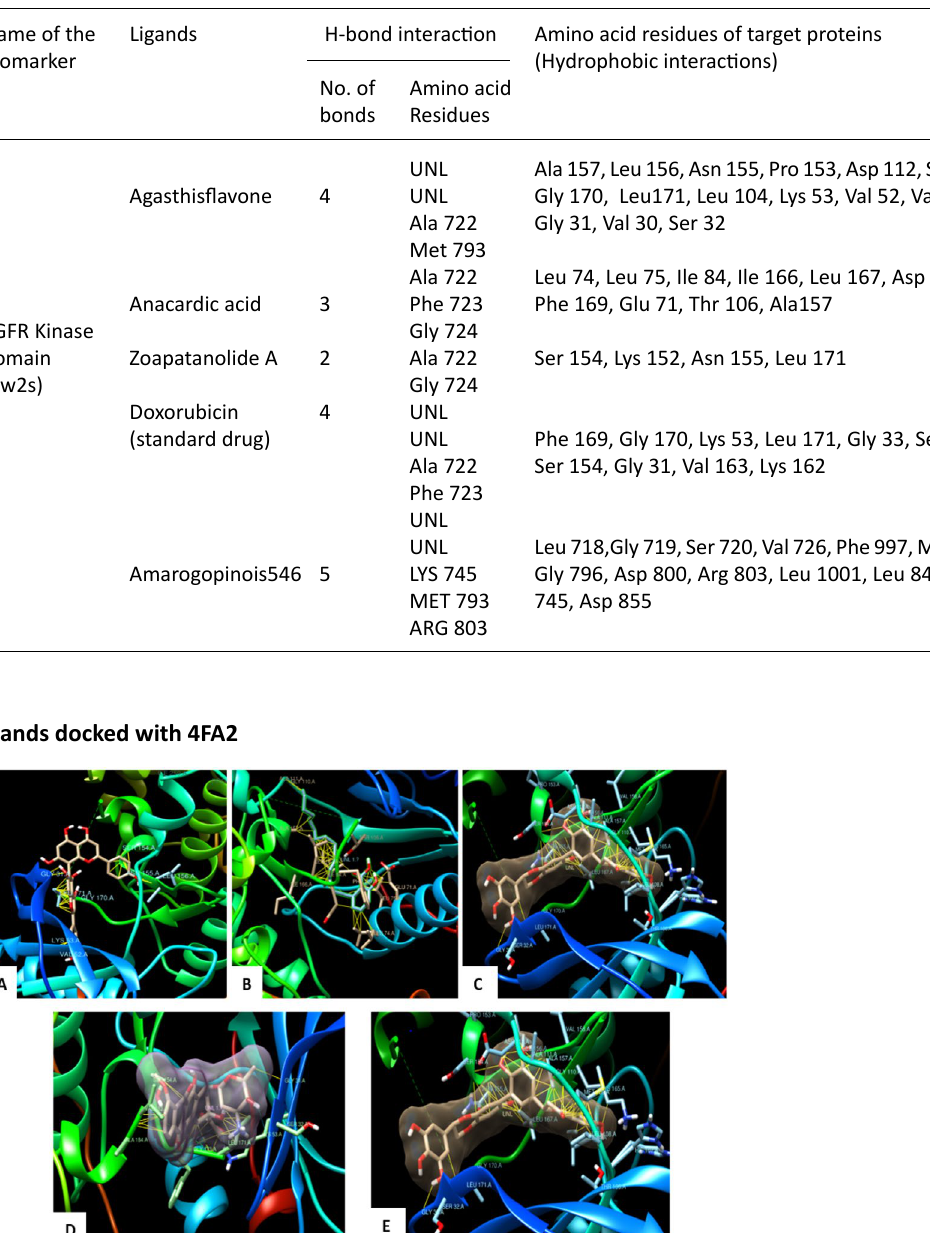
table 3. Residues of the target molecule EGFR Kinase domain interacting with Zoapatanolide A, Agasthisflavone, Anacardic acid, a standard drug Doxorubicin and Amarogopinois546